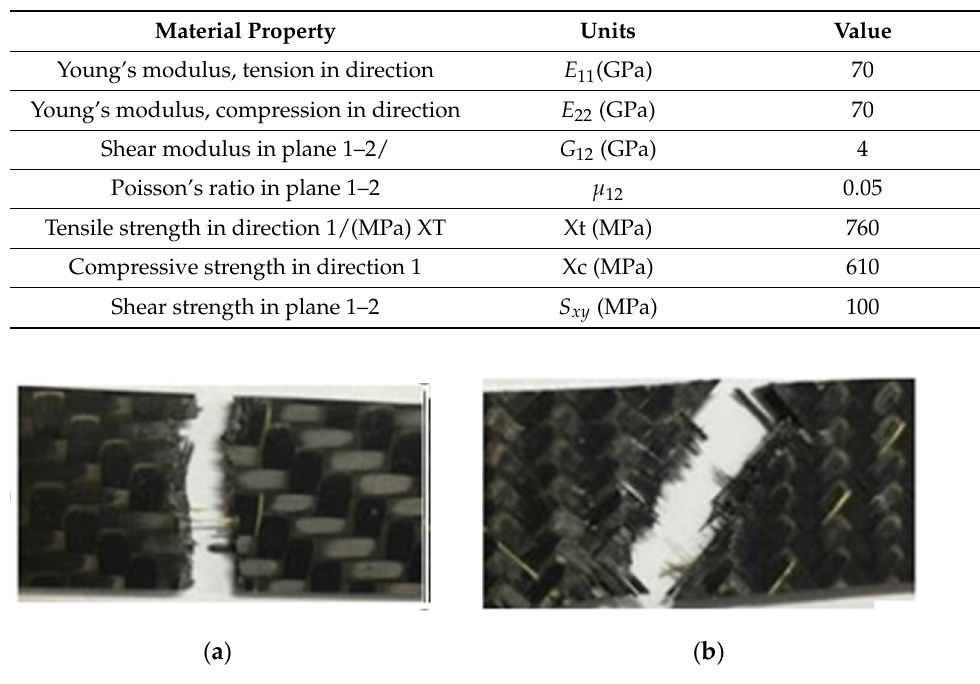
Figure 4. Composite samples under quasi-static loading, ( a ) 0/90 and ( b ) ±45 orientation. Table 1. Mechanical properties of MTM44-1/CF5804A obtained from tensile test.